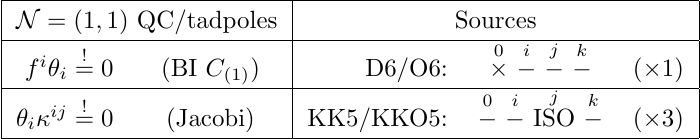
Table 7 . Non-vanishing QC (3.6), (3.8) and their higher-dimensional origin for the (cid:13)ux compacti(cid:12)- cation of type mIIA with O8/D8 given in table 5, where BI stands for Bianchi identities and Jacobi refers to the condition (2.10). A description of the QC as restrictions for the existence of additional local sources is